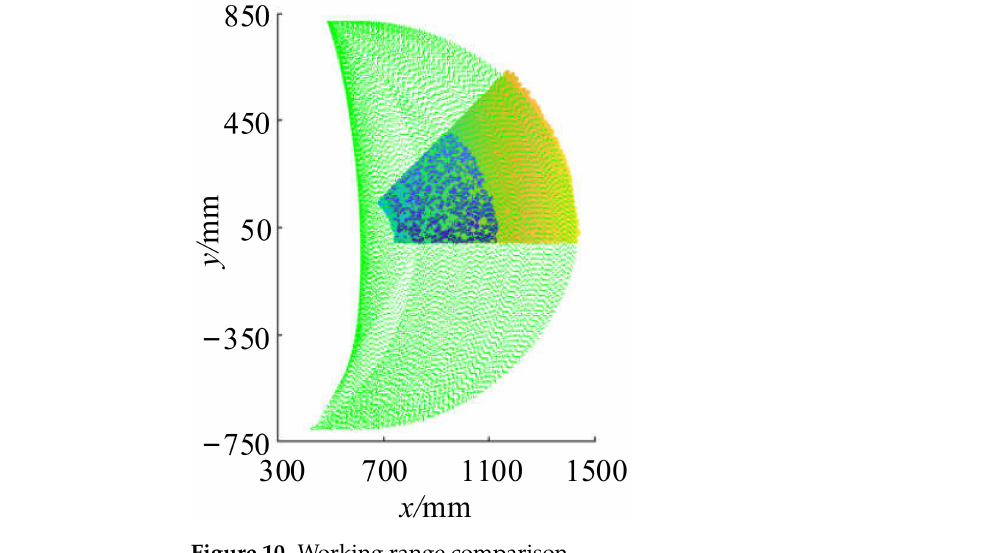
Figure 10. Working range